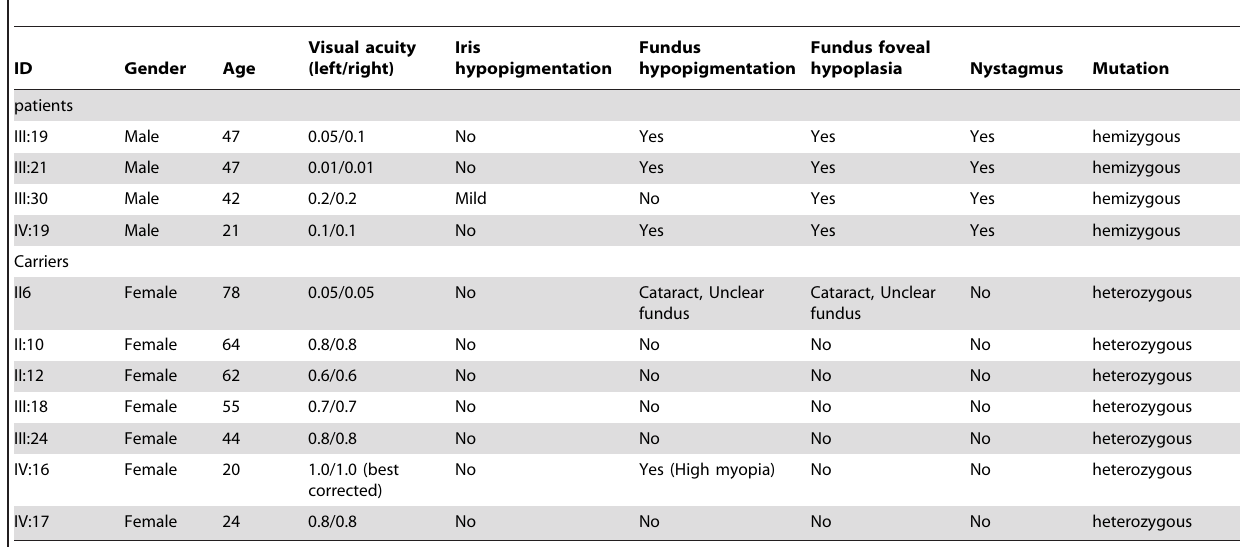
Table 2. Summary of clinical features of affected males and female